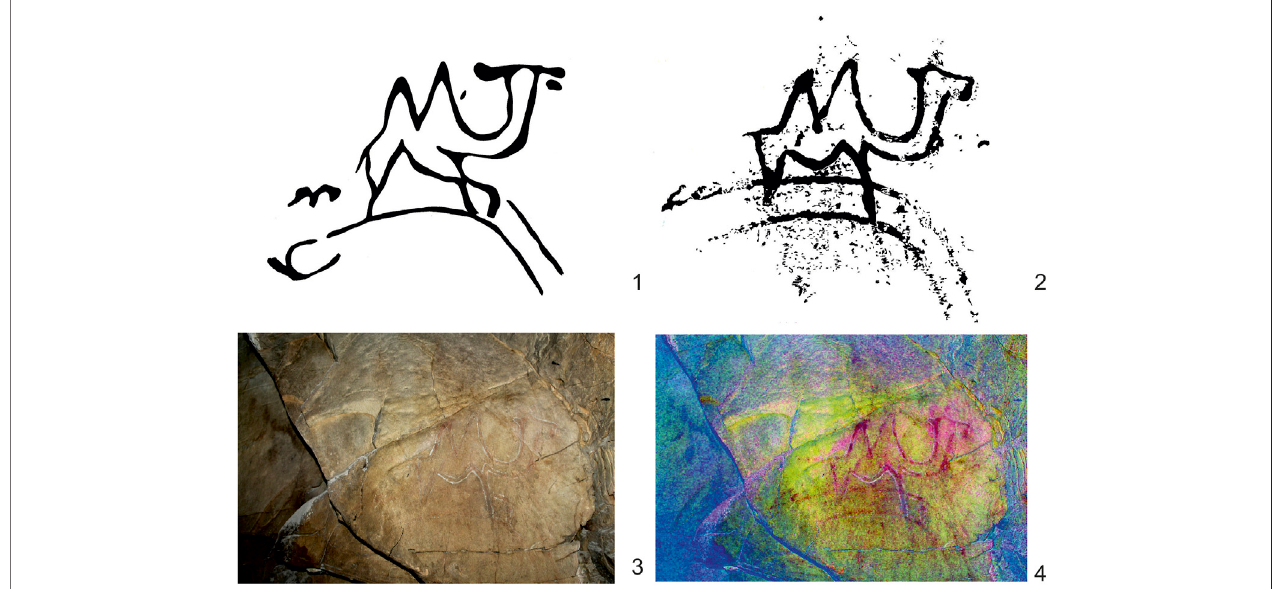
FIGURE8| PurportedlyPaleolithicimageofacamelinKhoidTsenkheriinAguiCave,MongolianAltai:1 – widelypublisheddrawingbyAcademicianA.P.Okladnikov in the 1970s (Okladnikov 1972); 2, 3, 4 – drawing made from a photograph taken for this study and enhanced in iDStretch (version 2.2., created by Jon Harmon).